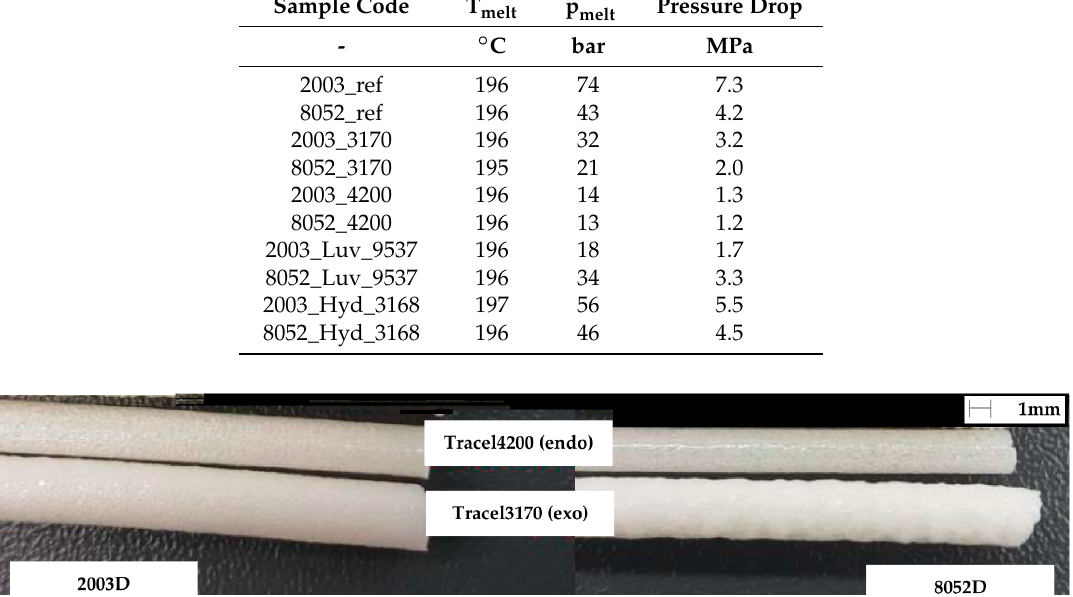
Figure 7. The surface of 2003_3170, 2003_4200 and 8052_3170, 8052_4200 foam structures manufactured at 190 °C. Table 7. Manufacturing parameters.